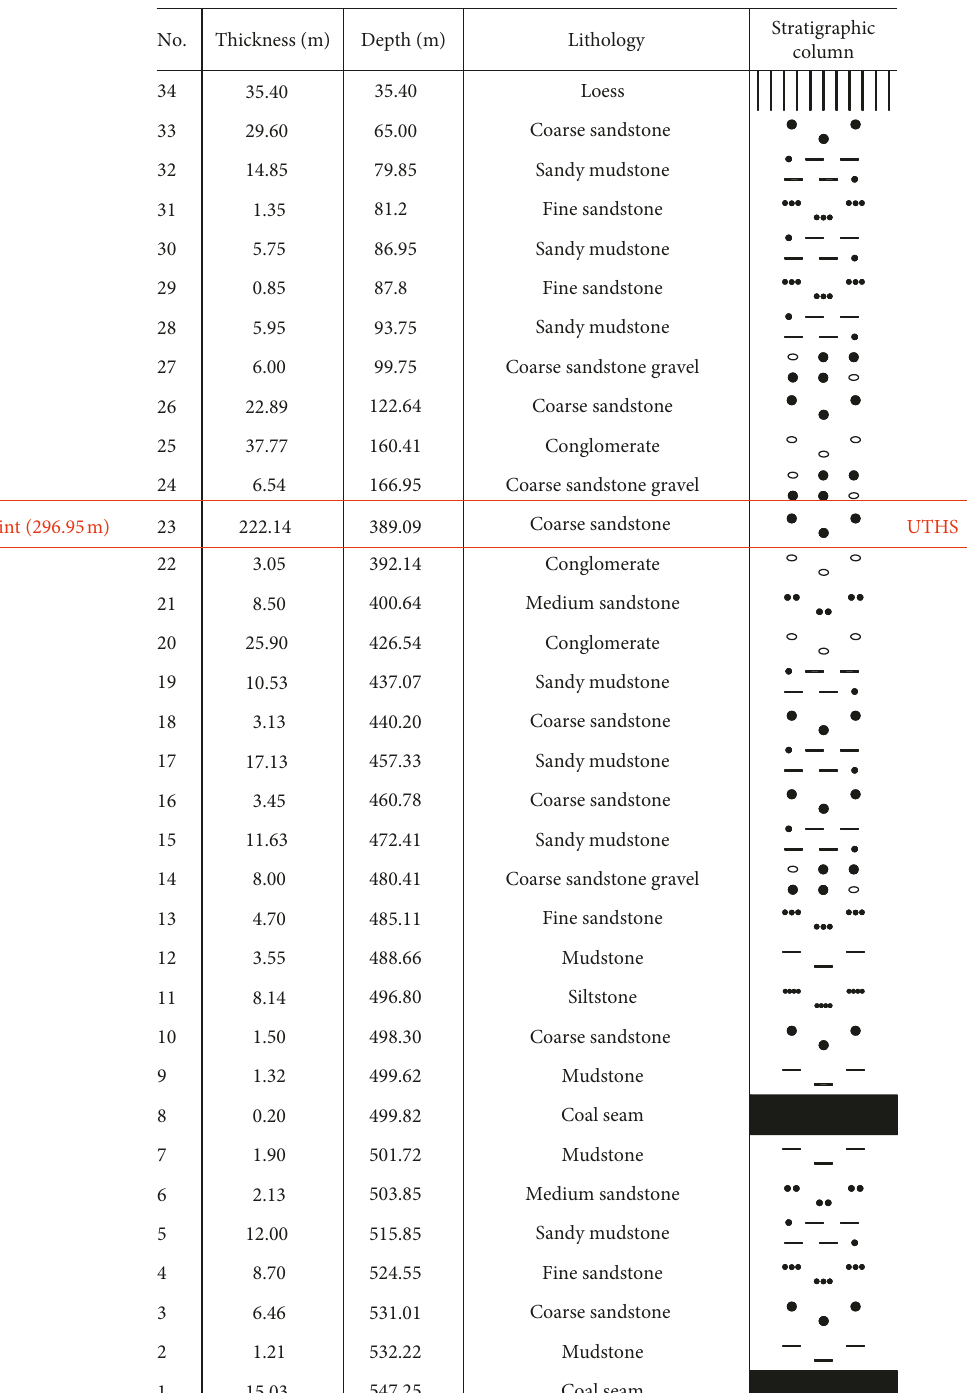
Figure 2: The integrated stratigraphic column in the second